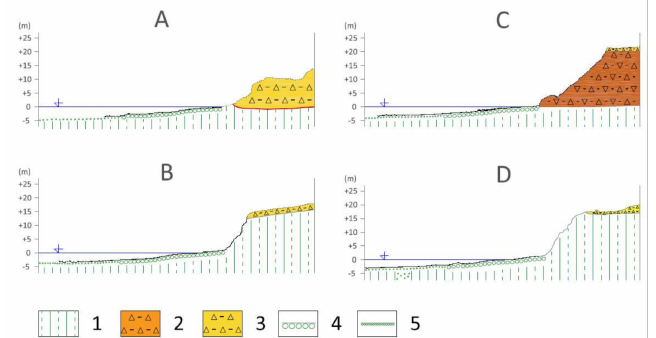
Figure 5. Engineering geological cross sections A , B , C , D (Figure 4): 1—Flysch rocks, 2—Talus breccia, 3—Colluvium, 4—Gravel and pebble (beach body), 5—Marine sand.